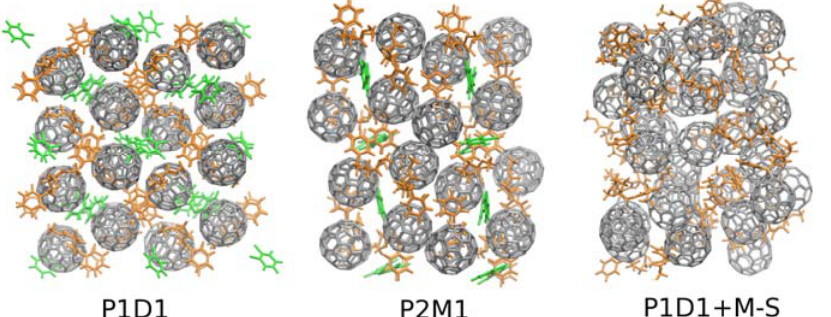
Fig. 4. Snapshots from MD simulations of P1D1 (cocrystal with ortho -dichlorobenzene), P2M1 (cocrystal with monochlorobenzene) and P1D1+M-S (a model for amorphous, solvent-free PCBM). Fullerene portions of PCBM are shown in grey, side chains in orange, solvent molecules in